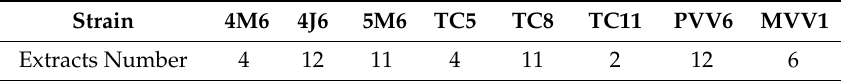
Table 3. Extract number inhibiting 50% bacterial